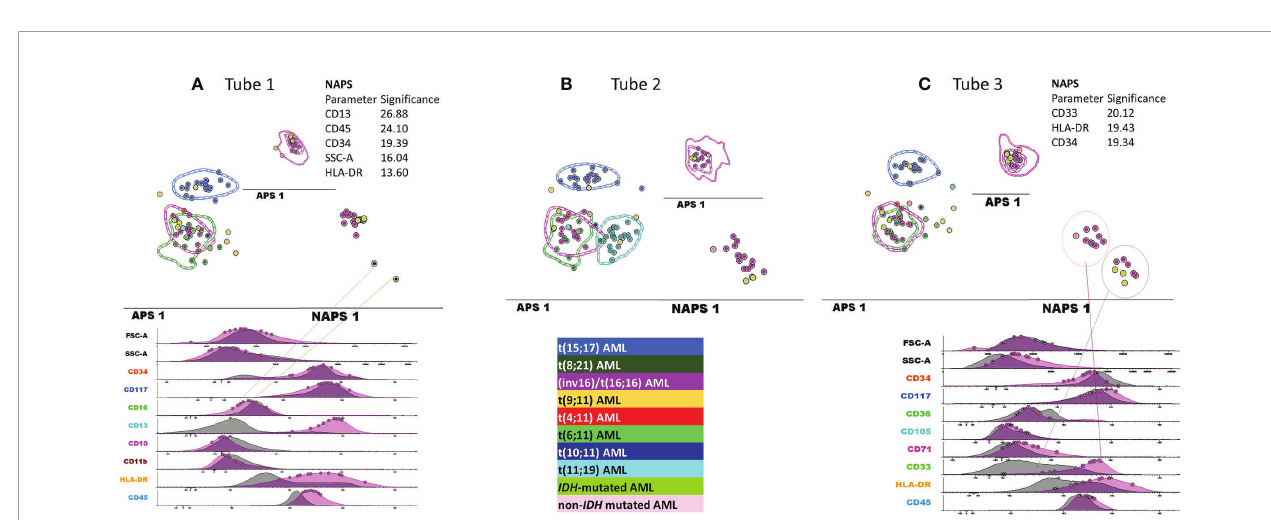
FIGURE 7 | Detailed evaluation of the false-positive inv(16)/t(16;16) AML cases. APS plots showing the overlap between the medians for the blast events from the false-positive inv(16)/t(16;16) AML cases (green-yellow, IDH mutated and pale rose circles, non-IDH mutated) with those for the inv(16)/t(16;16) AML group (violet circles, the dotted line represents the 1 standard deviation (SD) curve for the group), the t(8;21) AML group (green circles, the dotted line represents the 1 SD curve for the group) using the fi rst three tubes of the EF AML/MDS panel (A) tube 1 EF AML/MDS panel; (B) tube 2 EF AML/MDS panel, (C) tube 3 EF AML/MDS panel.